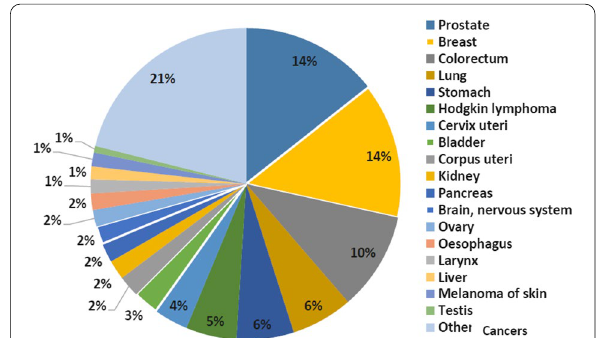
Fig. 1 Estimated distribution of cancer incidence, per tumor sites, in Nigeria